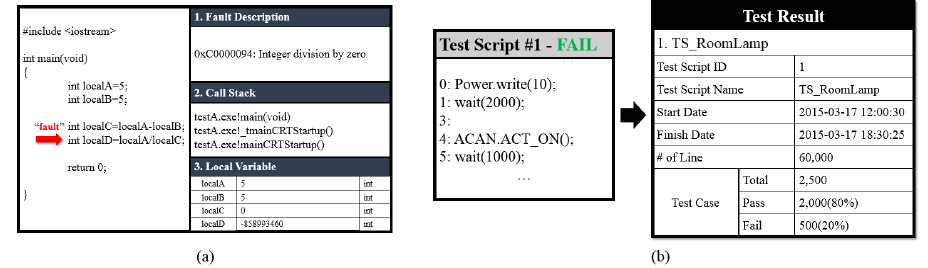
Figure 2. Debugging information with/without source code. ( a ) Debugging information with source code; ( b ) debugging information without source code.